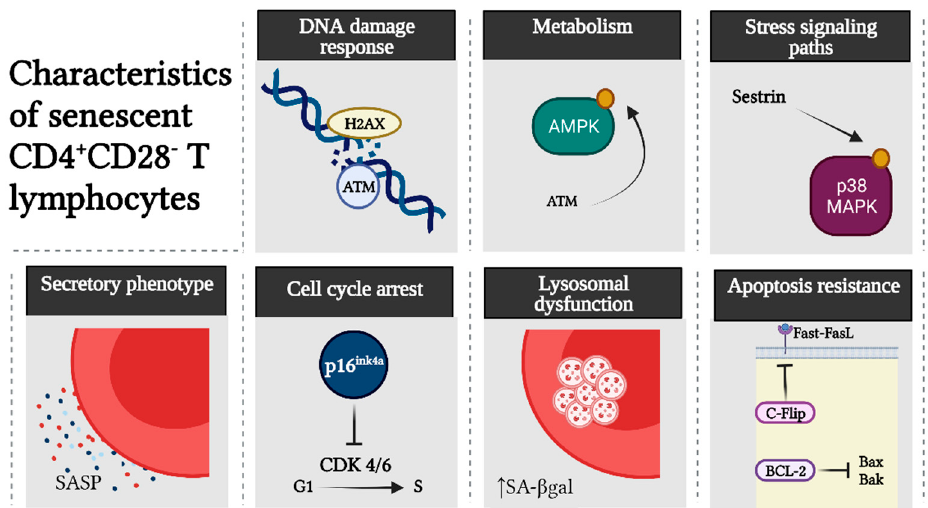
Figure 3. Hallmarks of senescent CD4 + CD28 − T lymphocytes. In contrast to their non-senescent counterpart, senescent CD4 + CD28 − T lymphocytes show activation of the DNA damage response (DDR) by ataxia-telangiectasia mutated (ATM) and phosphorylation of H2A histone family member X ( γ -H2AX). ATM signaling in these cells leads to phosphorylation of AMP-activated protein kinase (AMPK) and subsequently through a sestrin-mediated signaling pathway to p38 MAPK. Senescent CD4 + CD28 − T lymphocytes also show increased secretion of pro-inflammatory and cytotoxic medi- ators attributed to a senescence-associated secretory phenotype (SASP) and upregulated cell cycle inhibitors, such as p16 ink4a , that block cell cycle progression from the G1 to the S phase. In addition, they have lysosomal dysfunction, as evidenced by increased senescence-associated- β -galactosidase (SA- β gal) activity, and are highly resistant to apoptosis by upregulating anti-apoptotic proteins such as Bcl-2 and cellular Flice-inhibitory protein (c-Flip).